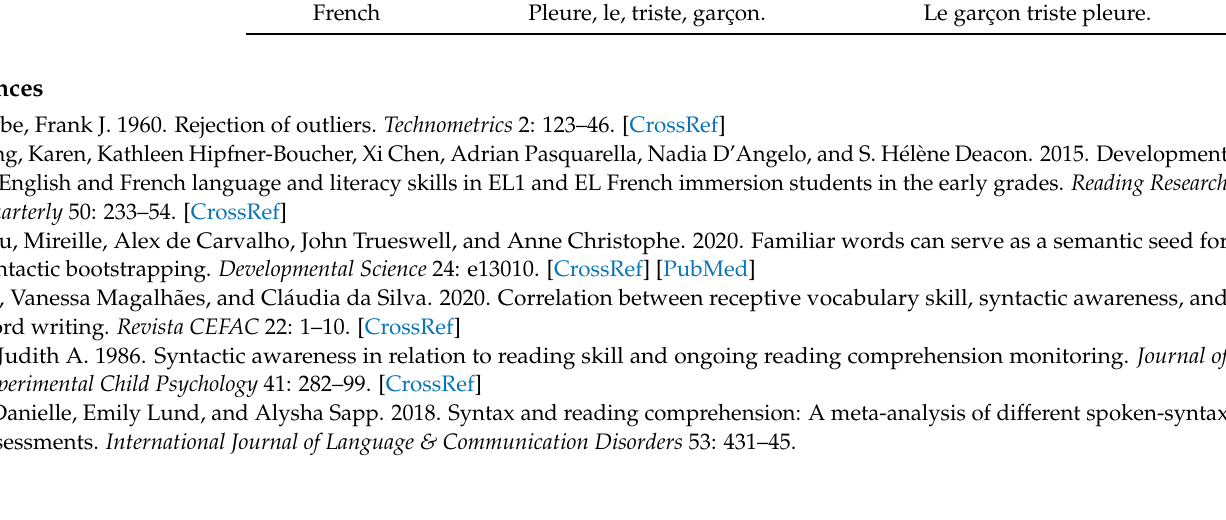
Table A1. Sample items from the syntactic awareness measure. Language Test Item Correct Response English The dog, by, were eaten, the cookies. The cookies were eaten by the dog. In her notebook, Jane, it,